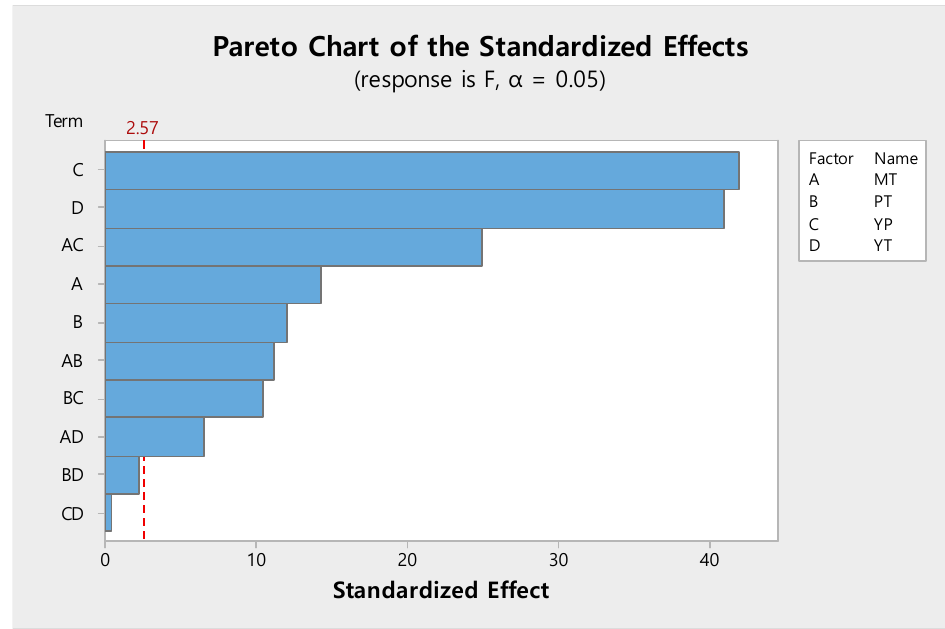
Figure 6. Responsivities of design parameters using full factorial design.